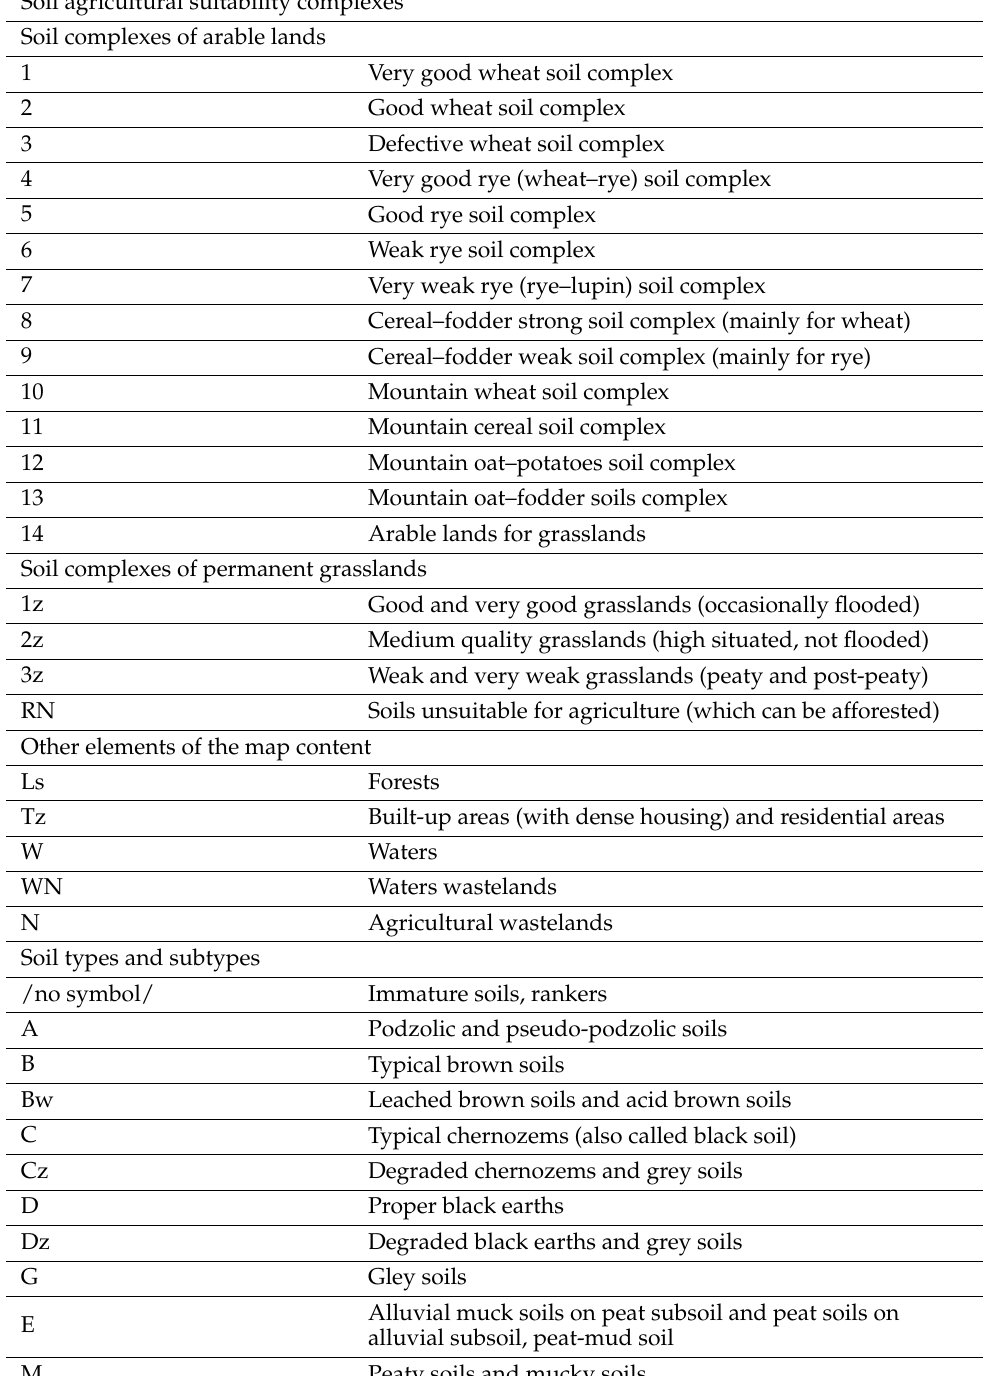
Table A1. Part of the description of Polish soil classification system used for the soil map at a scale of